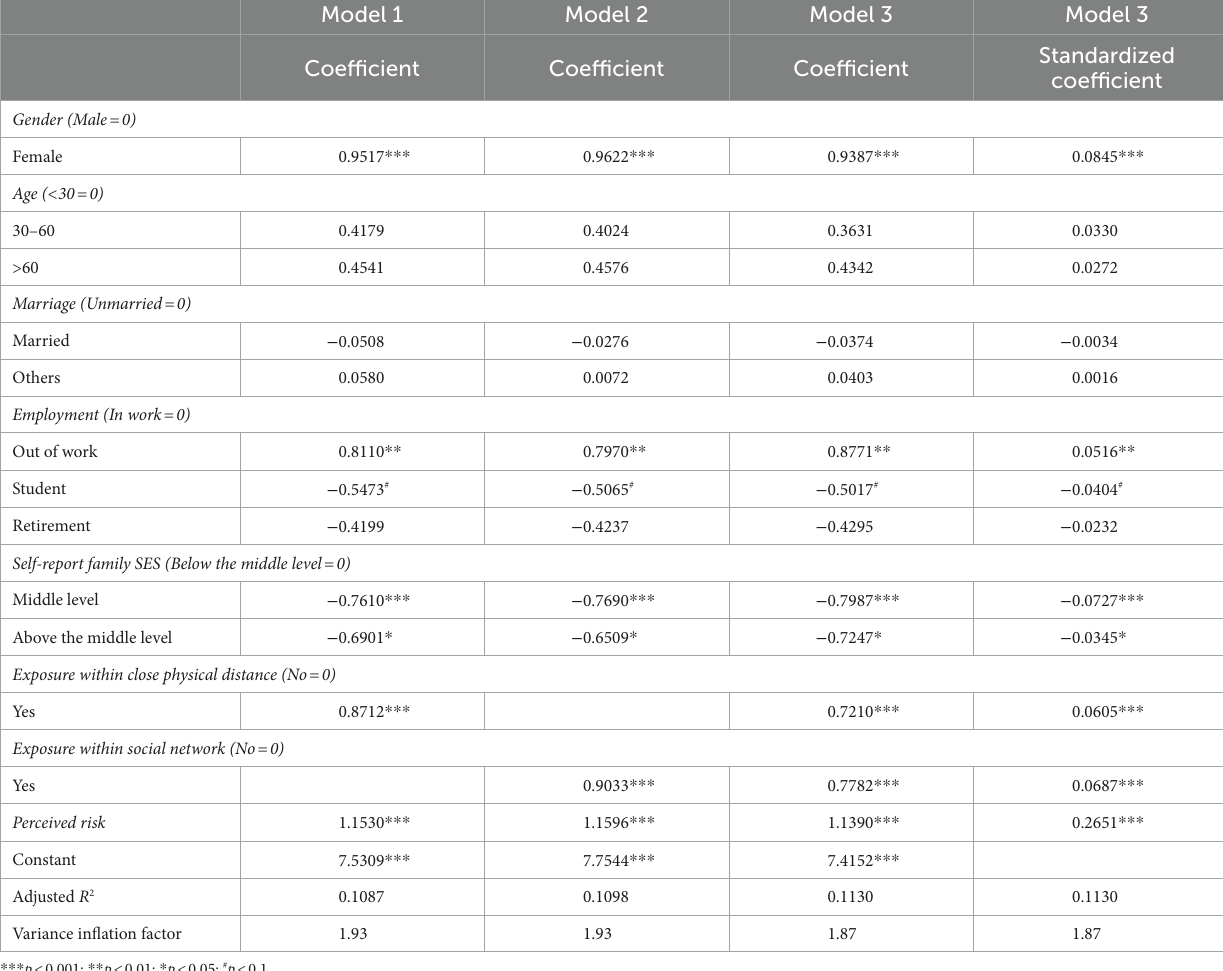
TABLE 2 Results of three multivariate linear regressions ( N =